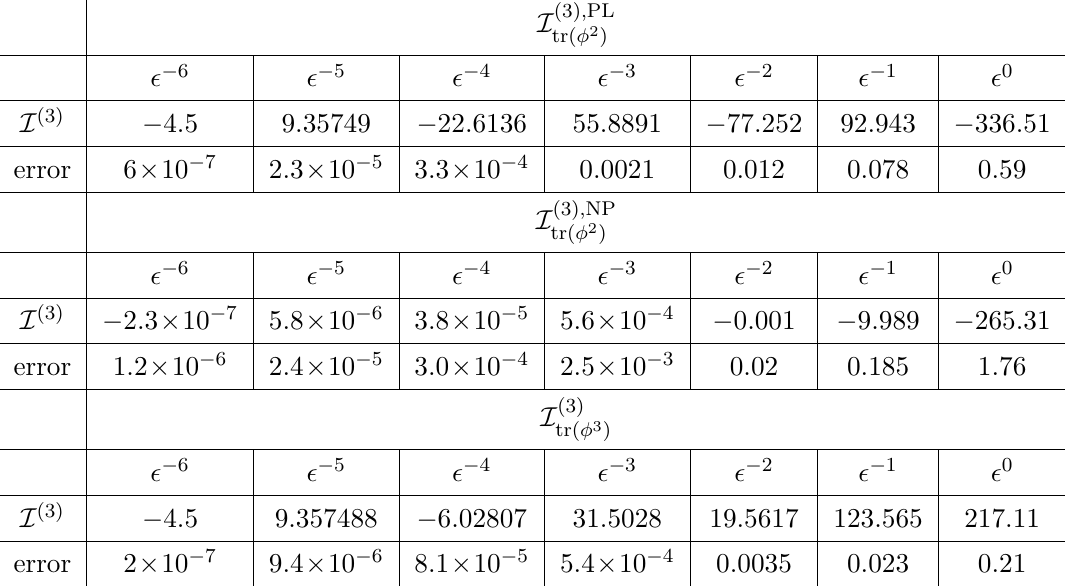
Table 1. Numerical results for the three-loop three-point form factors on the kinematics point ( s ) = ( − 2 , − 2 , − 2) 12 , s 23 , s 13